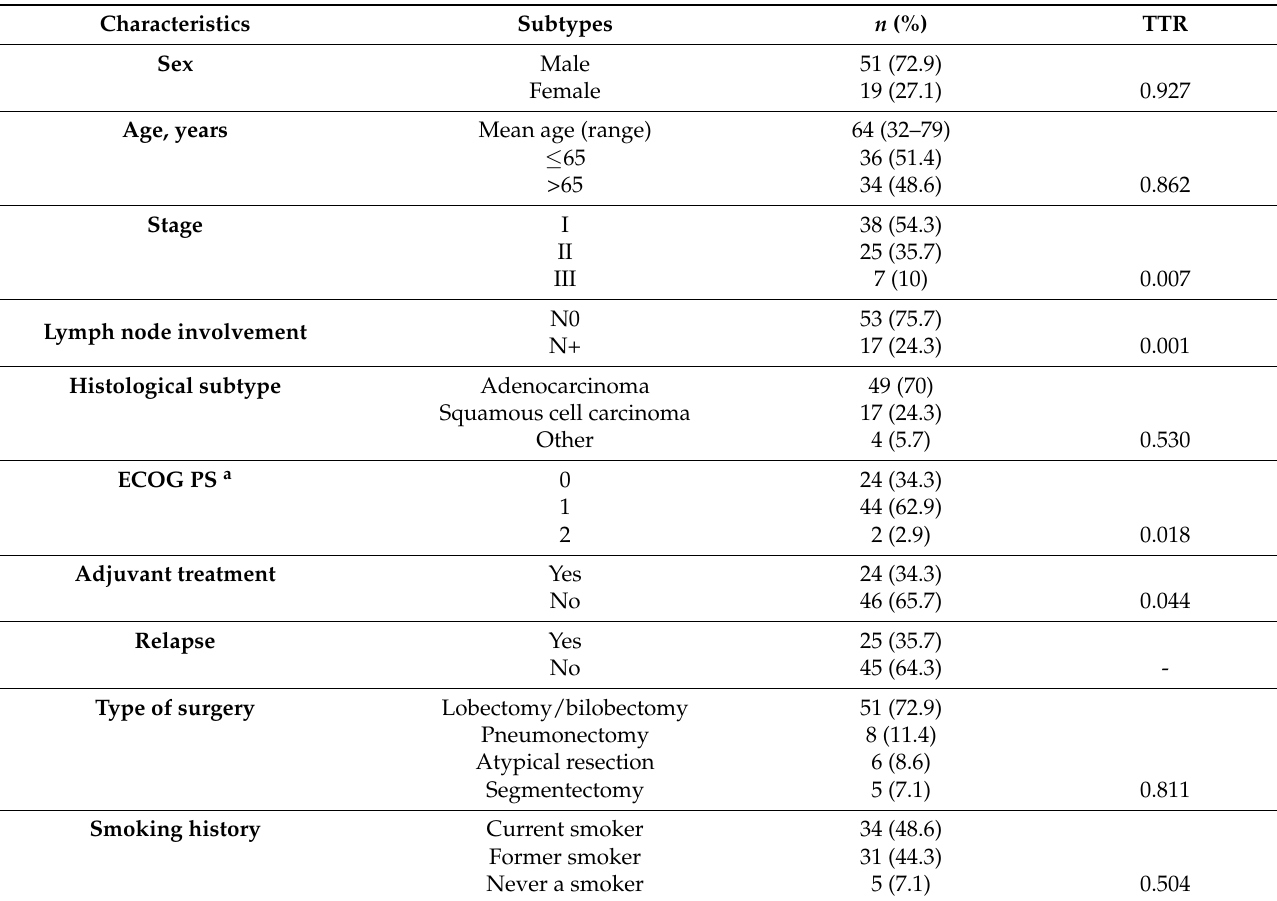
Table 3. Main clinical characteristics of validation cohort ( n =